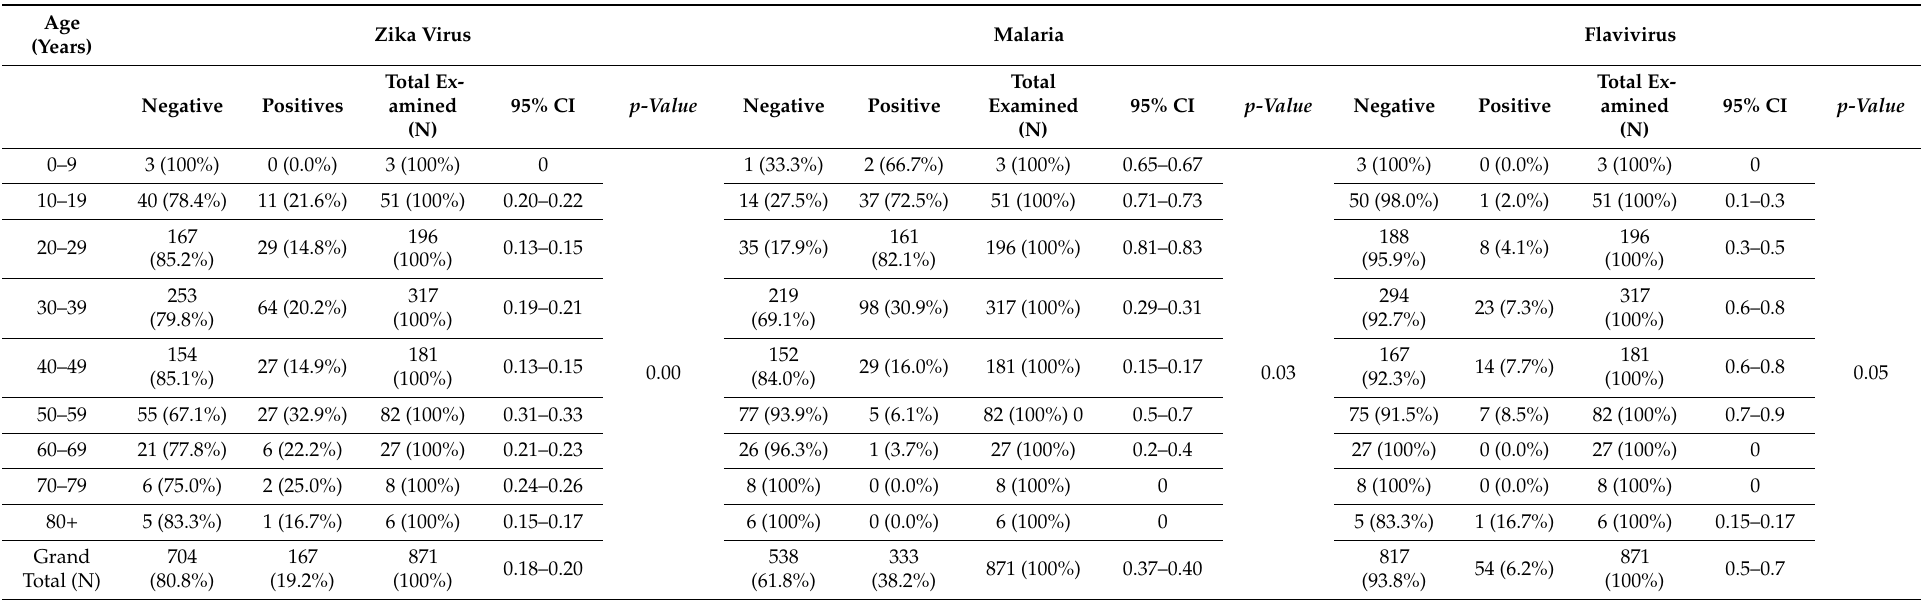
Table 3. Age-specific antibody seropositivity of Zika, FLAVI, and malaria